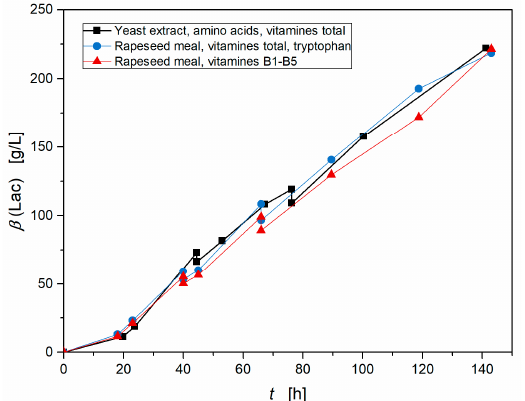
Figure 6. Lactic acid production by S. inulinus in a 2-step fed-batch with chemically hydrolyzed rapeseed meal as nutrient source (hydrolyzed with 3M H 2 SO 4 ) and comparison between supplementation with the complete B-vitamins, minimal supplementation with vitamins B1–B5 and a similar attempt based on yeast extract, incubated at 38 ◦ C, 0